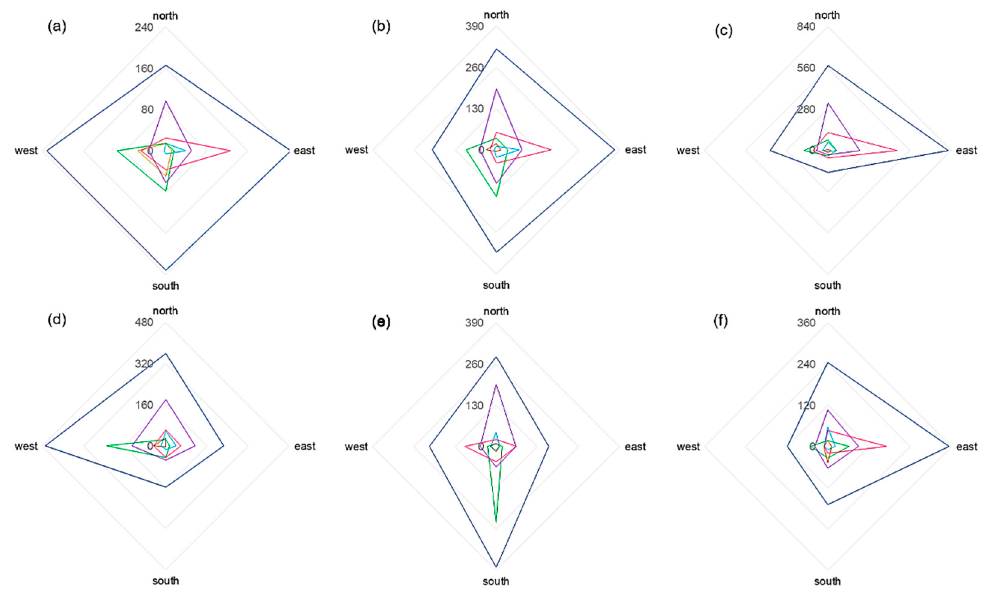
Figure A9. Pollen impaction (pollen grains/cm 2 ) on the vertical slides in 2020 for the pollen seasons: pre-pollen season: 11.03–17.03 (green), first main pollen season: 17.03–27.03 (pink), interruption: 27.03–03.04 (light blue), second main pollen season: 03.04–17.04 (purple), post-pollen season: 17.04–01.05 (brown) and total (dark blue).For pollen traps 1 ( a ), 2 ( b ), 3 ( c ), 4 ( d ), 5 ( e ) and 6 ( f ) at the location Emmendingen.